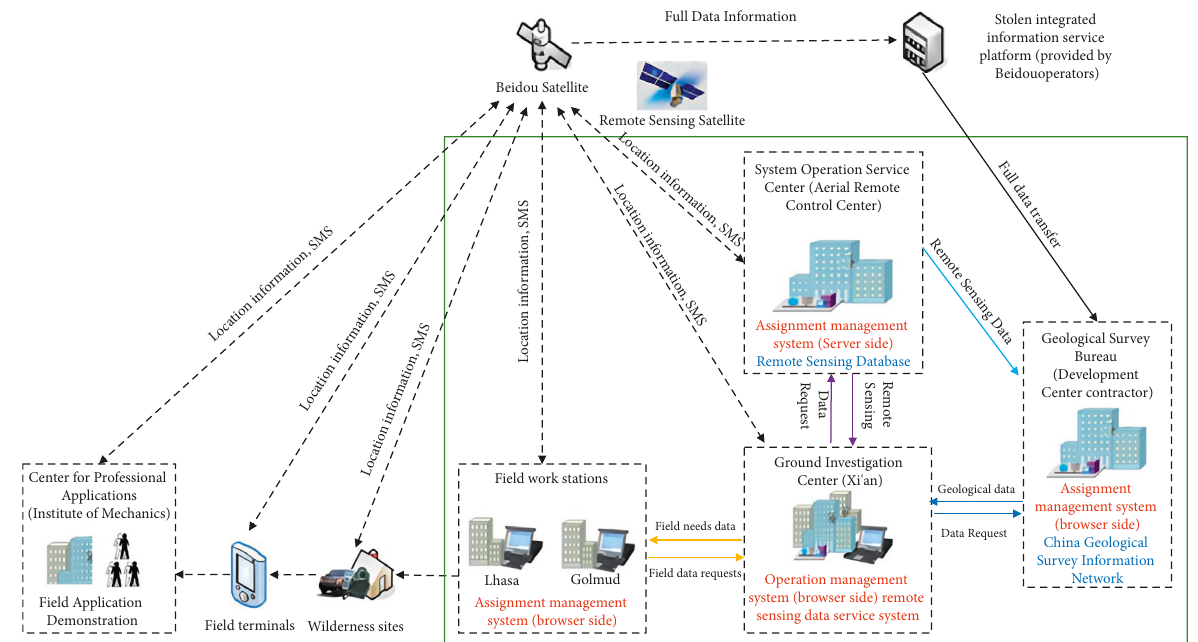
Figure 1: Evaluation system of rural land resources based on improved GIS.